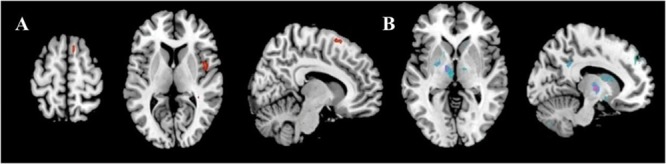
Activation volumes show significant differences before and after exhaustive exercise. (A) After > before; (B) Before > after.